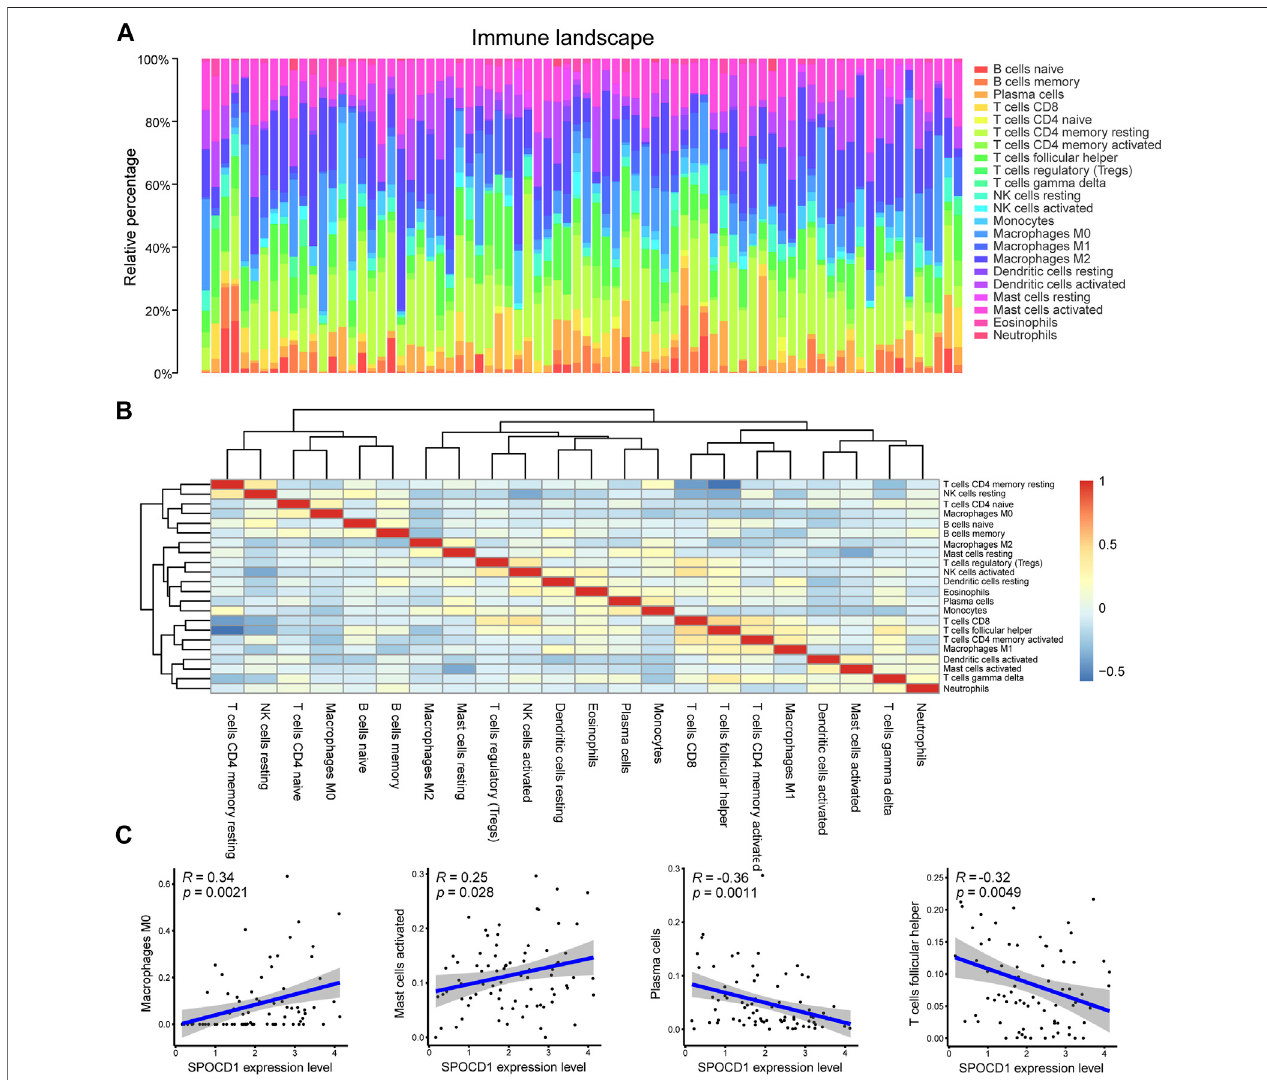
FIGURE 9 | Evaluation and correlation analysis of immune cell in fi ltration. (A) Panoramagram of 22 kinds of immune cell in fi ltration in TCGA-ESCC tumor samples; (B) Correlation heat map of 22 kinds of immune cell score; (C) Correlation between SPOCD1 gene expression and immune cell in fi ltration. TCGA, The Cancer Genome Atlas; ESCC, esophageal squamous cell carcinoma; SPOCD1, SPOC Domain Containing